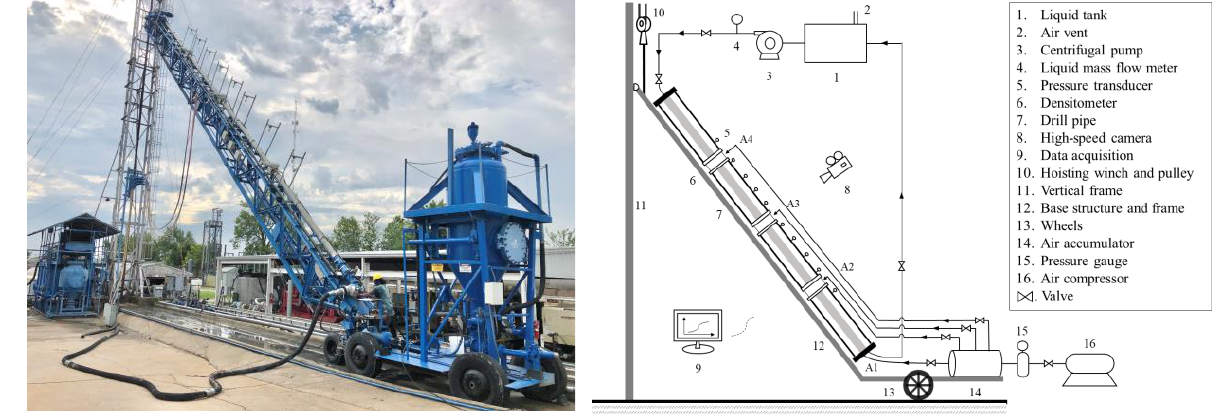
Figure 1. General view and schematic view of the experimental facility.